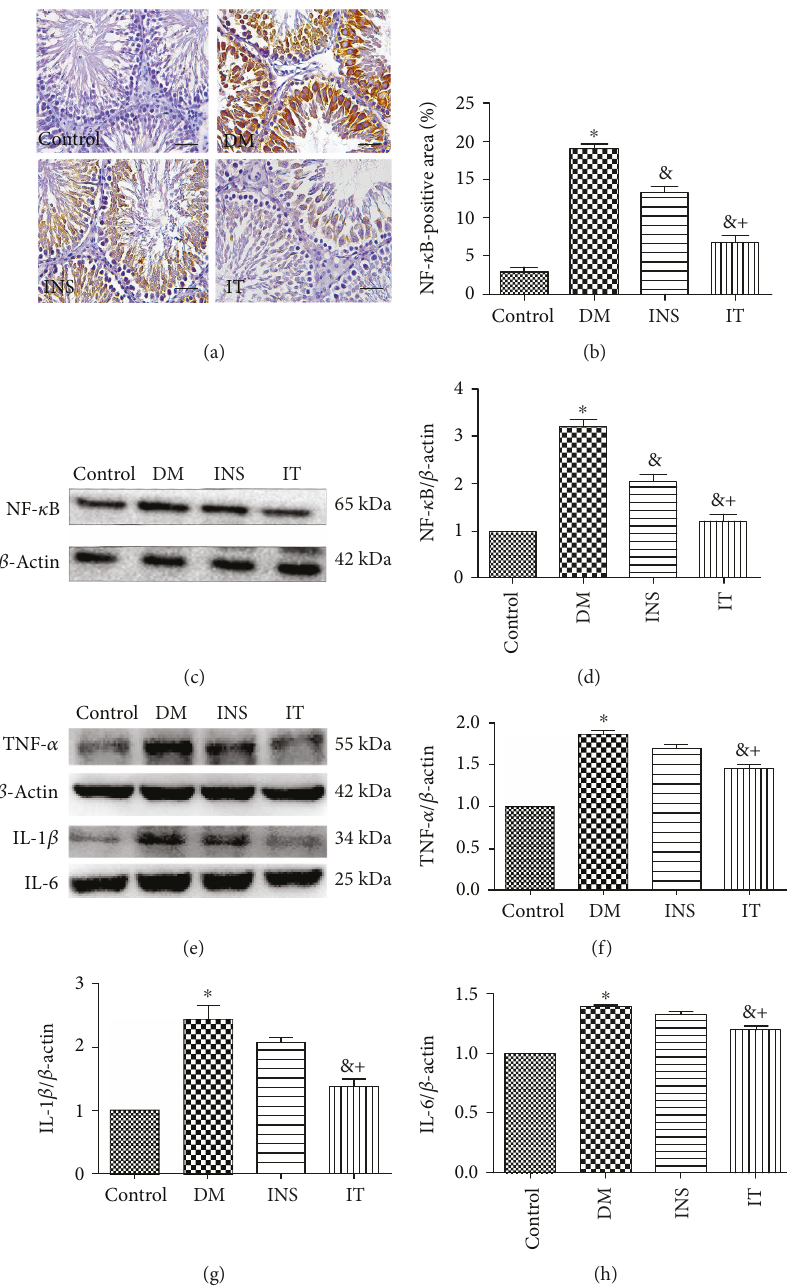
Figure 5: Islet transplantation treatment inhibited NF- κ B expression in diabetic rats. (a, b) NF- κ B levels measured by immunohistochemical staining ( × 400) (bar=25 μ m) and quantitative analysis of positive regions showed that the increase in NF- κ B was signi fi cantly improved in the INS group compared with that in the control group; IT attenuated the expression of the protein ( n = 6 for each group). (c, d) Western blot images of NF- κ B and quantitative analysis of its expression levels in the DM group revealed signi fi cant upregulation. By contrast, NF- κ B in the IT group was signi fi cantly downregulated compared with that in the INS group ( n = 6 for each group). (e – h) Typical Western blot images of TNF- α , IL-1 β , and IL-6 intesticular tissues and quantitative analysis of their expression levels. DM caused a signi fi cant increase in the above parameters. The IT treatment group signi fi cantly reduced the expression of TNF- α , IL-1 β , and IL-6. The expression of the above proteins in the INS group was only slightly altered ( n = 6 for each group). DM: diabetes mellitus; INS: insulin treatment; IT: islet transplantation. ∗ P < 0 05 vs. control; & P < 0 05 vs. DM; + P < 0 05 vs.